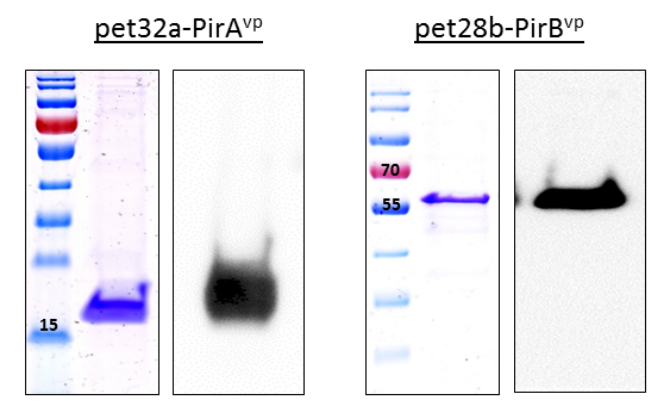
Figure 1. The expression of PirA vp and PirB vp was verified through Coomassie staining and Western Blotting. After purification using His resin, PirA vp was evident as a band at ~15 kDa (using His Ab for detection), while PirB vp was purified using Streptactin resin and a band evident at ~55 kDa size (using Streptactin-HRP for Western blot